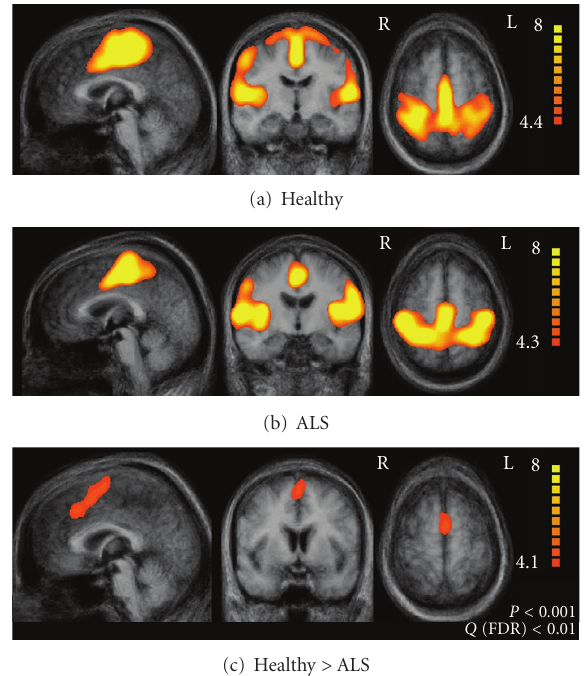
Figure 5: Sensori-motor network. Upper row (a) illustrates the result of the group ICA analysis for the healthy control participants, the middle row (b) illustrates the results for the ALS patients. The statistical comparison is shown in the lower row (c). Adapted from Mohammadi and co-workers